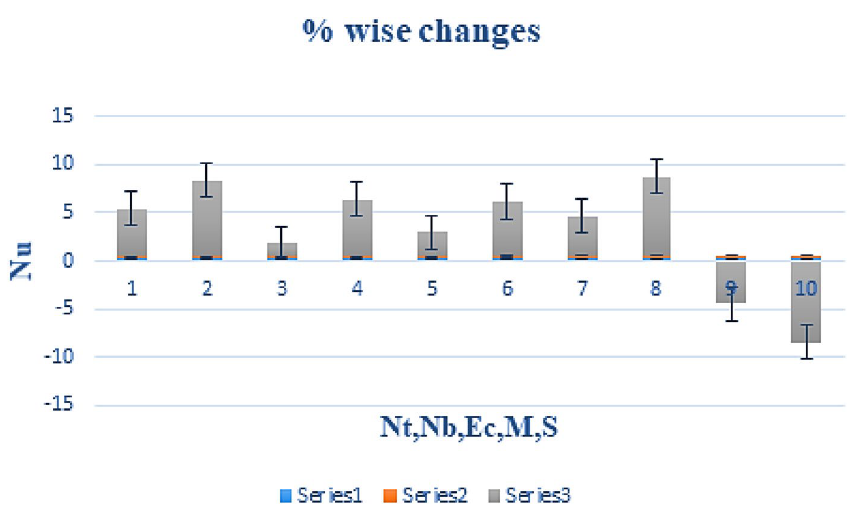
Figure 17. % Wise change in the heat transfer rate due to the variation In parameters Nt , Nb , Ec , M and S . When Pr = 6.2, Gc = Gr = 0.2, Ec = 1